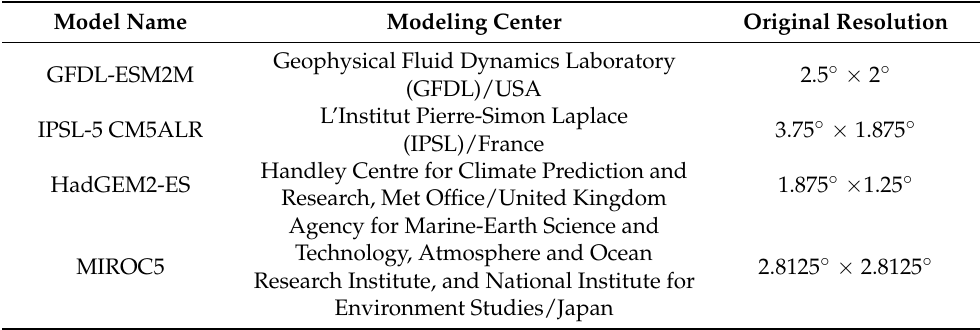
Table 1. List of 4 CMIP5 models used in our